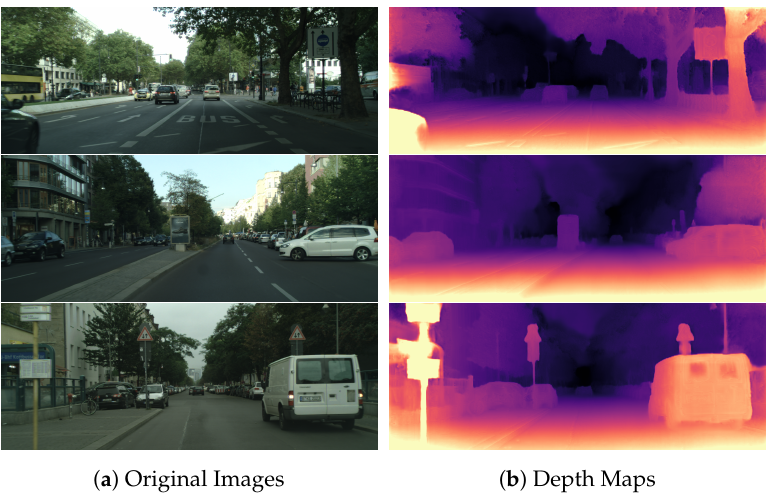
Figure 7. Qualitative results with CityScapes.